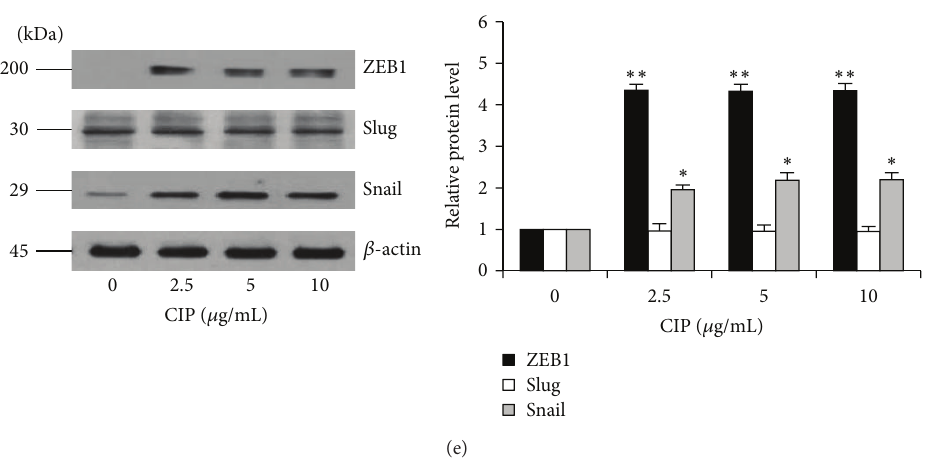
Figure 5: Effects of CIP on stem cell-like phenotypes in primary human DPCs. (a) Cells were treated with CIP (0–10 𝜇 g/mL) for 24 h. Cytotoxicity was determined by MTT assay. The data represent the means of four independent triplicate samples ± SD. (b) After indicated treatment,modeofcelldeathwasexaminedbyHoechst33342/PIcostainingassay.Scalebaris100 𝜇 m.((c)–(e))CellsweretreatedwithCIP(0– 10 𝜇 g/mL) for 72 h. After indicated treatment, the levels of stem cell markers (procollagen type I, CD133, integrin 𝛽 1, and ALDH1A1), Wnt/ 𝛽 - catenin signaling (Akt, p-Akt, GSK3 𝛽 , p-GSK3 𝛽 , and 𝛽 -catenin), and EMT transcription factors (ZEB1, Slug, and Snail) were determined by western blot analysis, respectively. 𝛽 -actin was served as the loading control. The immunoblot signals were quantified by densitometry and mean data from independent experiments were normalized to the results. The data represent the means of four independent samples ± SD. ∗ 𝑃 < 0.05 and ∗∗ 𝑃 < 0.01 versus untreated